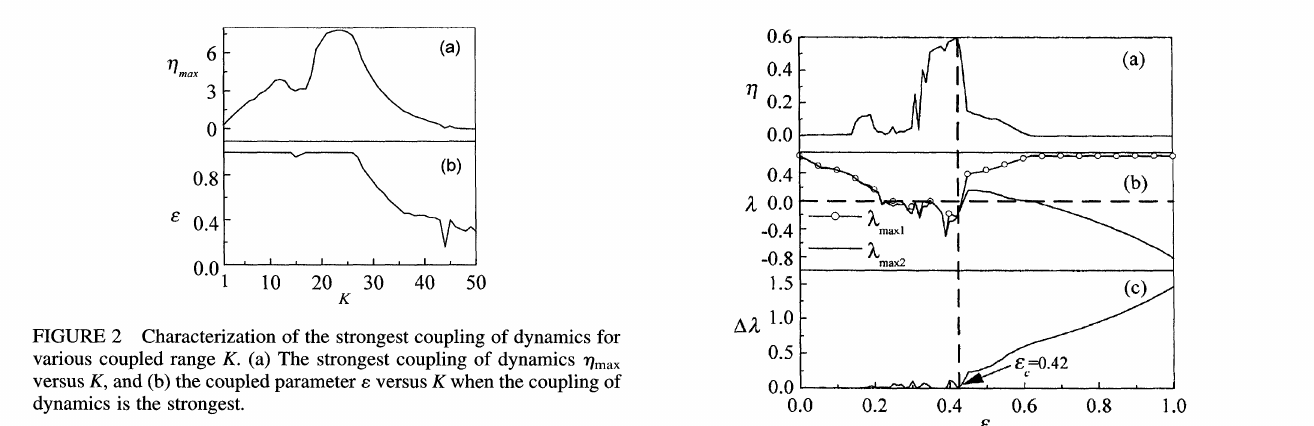
FIGURE 2 Characterization of the strongest coupling of dynamics for various coupled range K. (a) The strongest coupling of dynamics max versus K, and (b) the coupled parameter e versus K when the coupling of dynamics is the strongest. e are found for each K. The results are plotted in Fig. 2a, b.